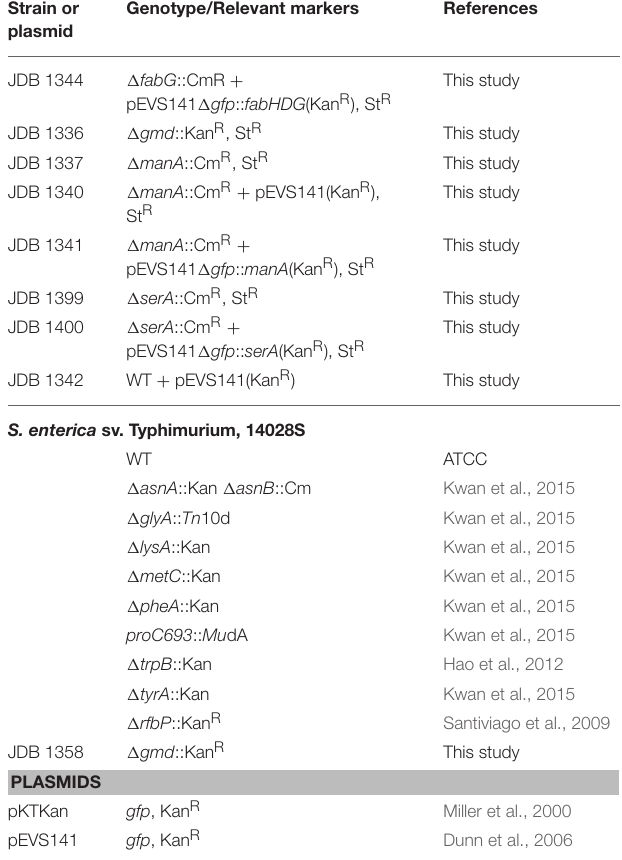
TABLE 1 | List of strains. Strain or Genotype/Relevant plasmid